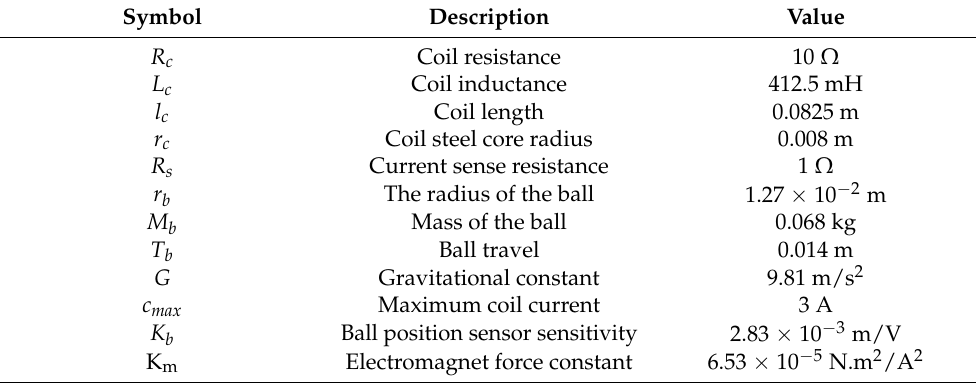
Table 1. Parameters of